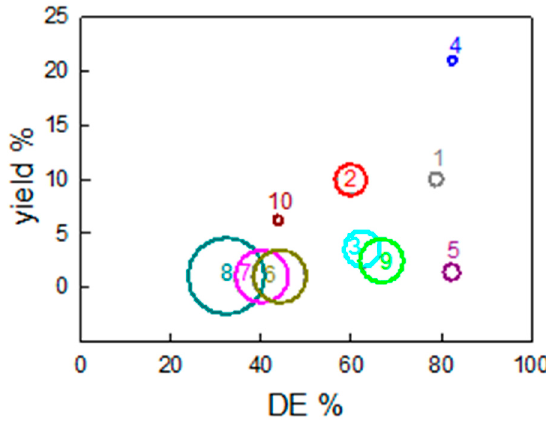
Figure 6. Comparison of extraction yield, esterification degree (DE) and energy investment necessary for the production of 10 g of pectin (amplitude of circle area) for each extraction. The number in/near the circle represents the extraction protocol.